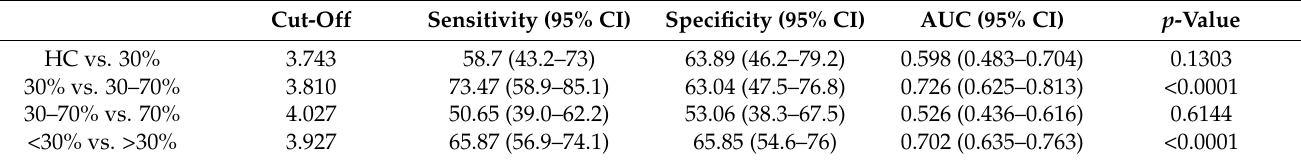
Table 3. Association of AACT among HC and CAD patients with stenosis rates of <30%, 30–70%, and